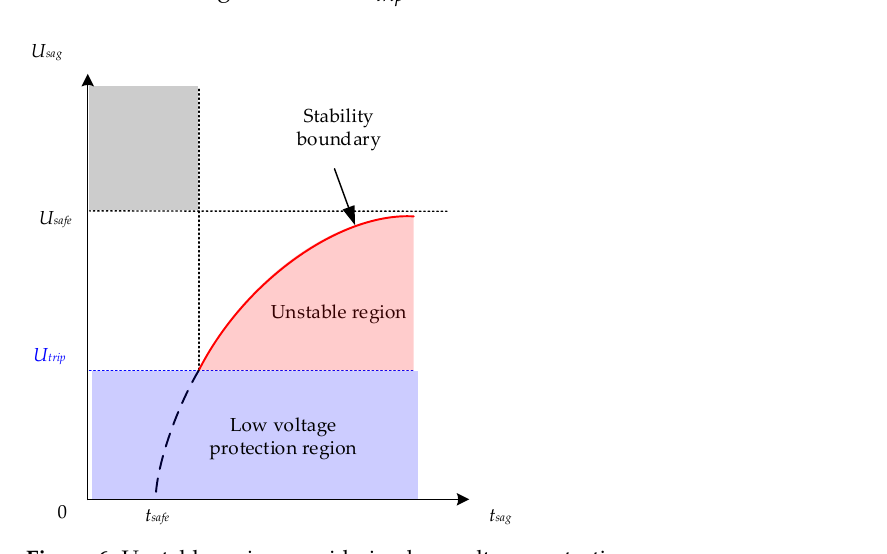
Figure 6. Unstable region considering low-voltage